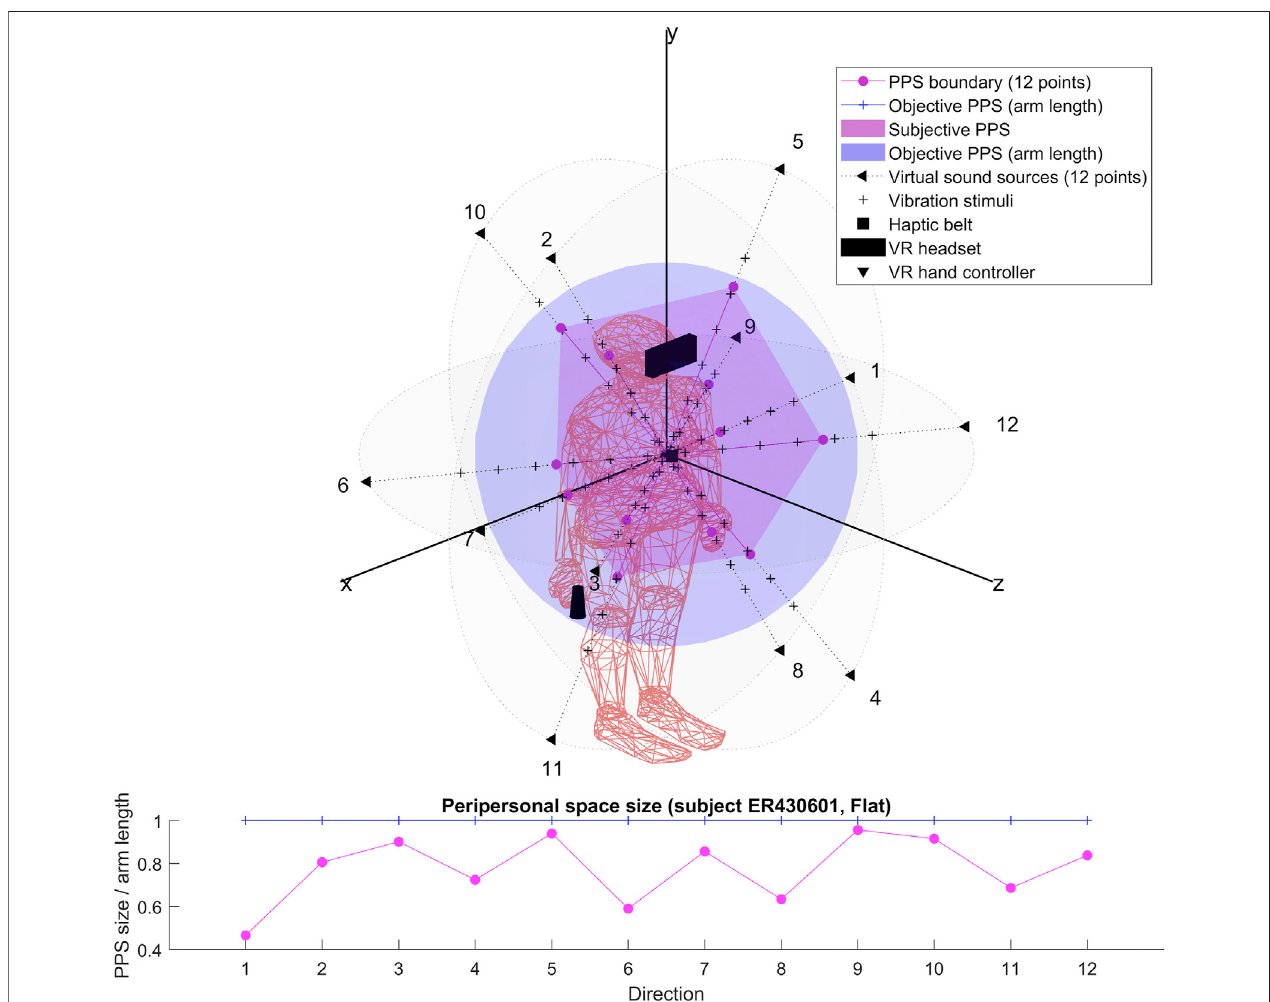
FIGURE 7 | PPS 3D representation for subject ER430601 fl at condition.